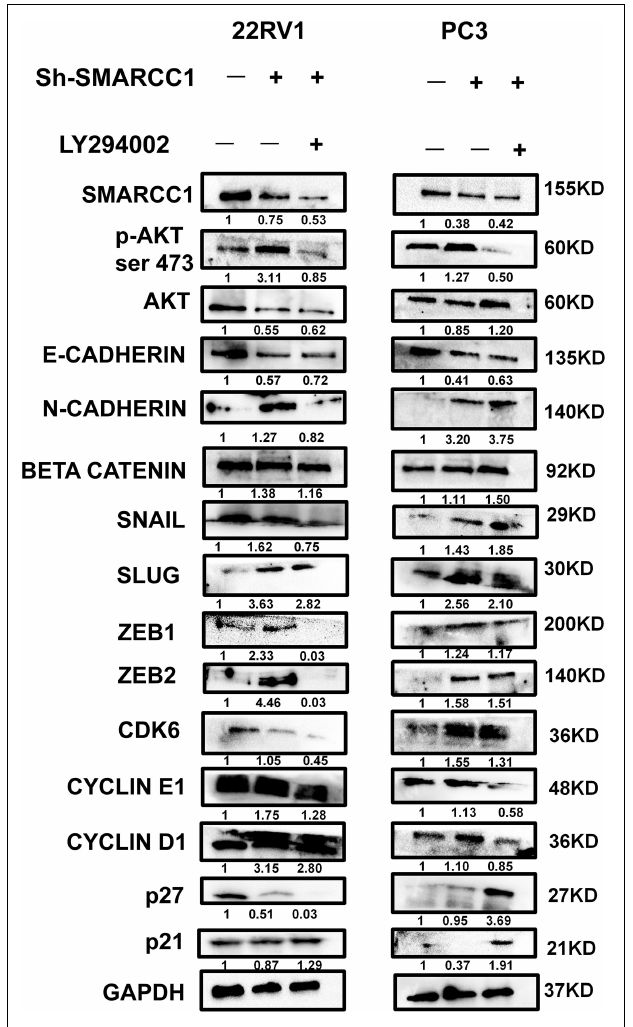
FIGURE 7 | PI3K/AKT pathway blockade with LY294002 partially reversed the protein expression in SMARCC1 knockdown PCa cells. The gray density values are indicated under the corresponding